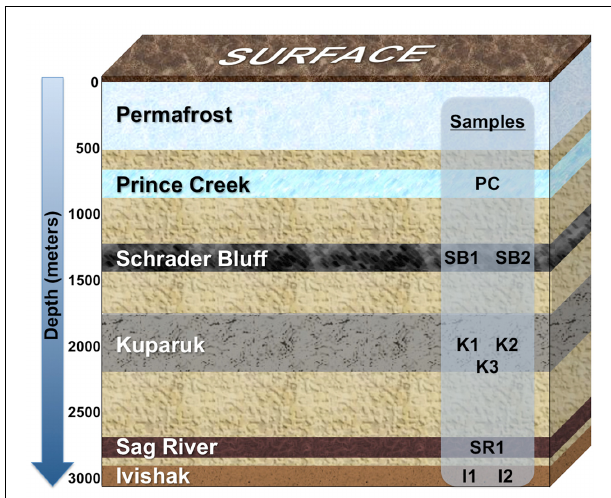
FIGURE 1 | Schematic showing relative positions of geological formations in the Milne Point and/or Prudhoe Bay fields, Alaskan North Slope. Formations extend over many miles of the Milne Point and/or Prudhoe Bay fields and may tilt in regions, so depth range averages were used to depict the relative positions of the formations; the depth of each formation is not to scale. Prince Creek Formation water is used as make-up water supporting secondary recovery from Schrader Bluff and Kuparuk Formations. Prince Creek water is also used for artificial lift of Sag River produced fluids. Seawater injection is used to support secondary recovery from the Ivishak reservoir. Wells sampled for this study are labeled according to the formation from which they